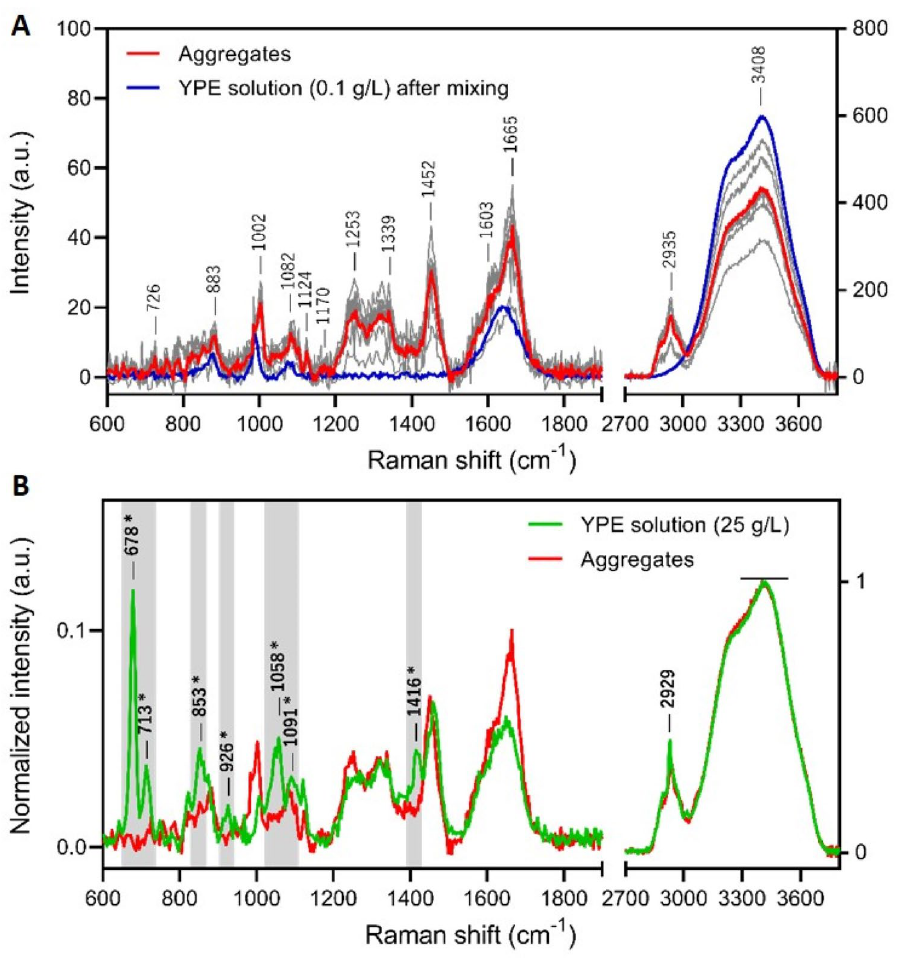
Figure 8. Raman spectra of protein aggregates and YPE solution. ( A ) Average Raman spectra of aggregates formed in YPE solution at 0.1 g/L (red) and YPE solution at 0.1 g/L after mixing (blue). The individual spectra of protein aggregates are shown in grey. ( B ) Normalized Raman spectra of protein aggregates formed in YPE solution at 0.1 g/L (red) and YPE stock solution at 25 g/L (green). The spectra were normalized to the OH band of water at 3406 cm −1 . * The Raman bands that are present in YPE solution but absent in protein aggregates are highlighted in grey.